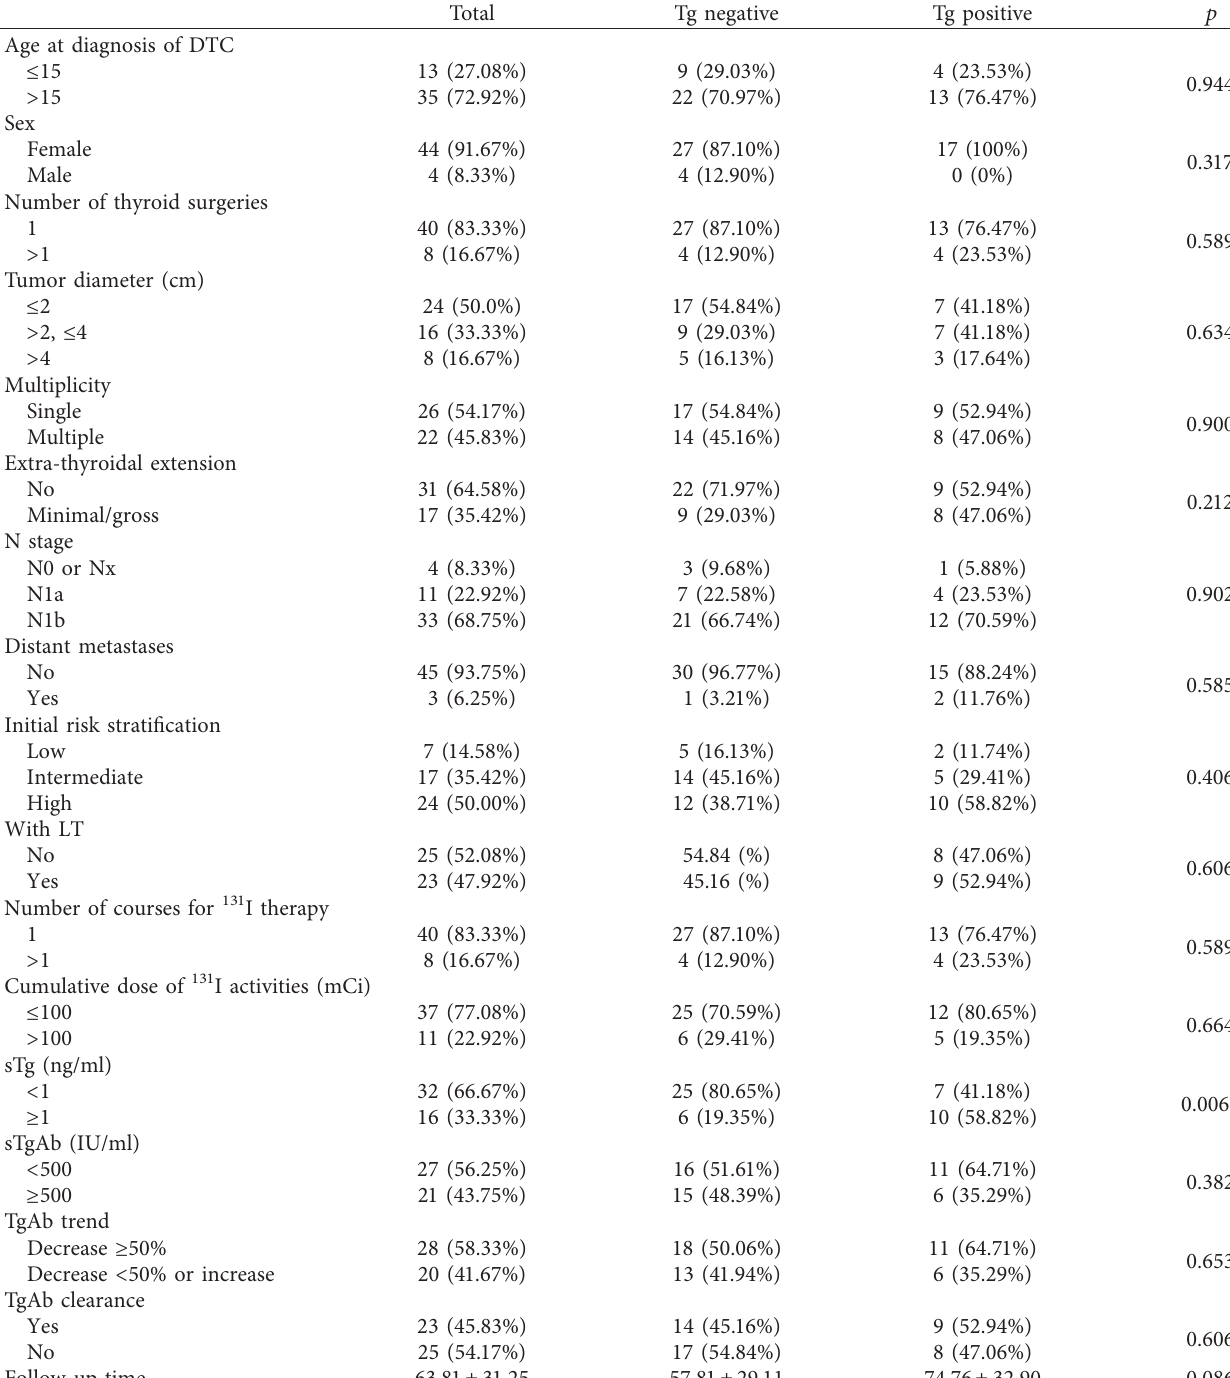
Table 1: Clinicopathological characteristics of all